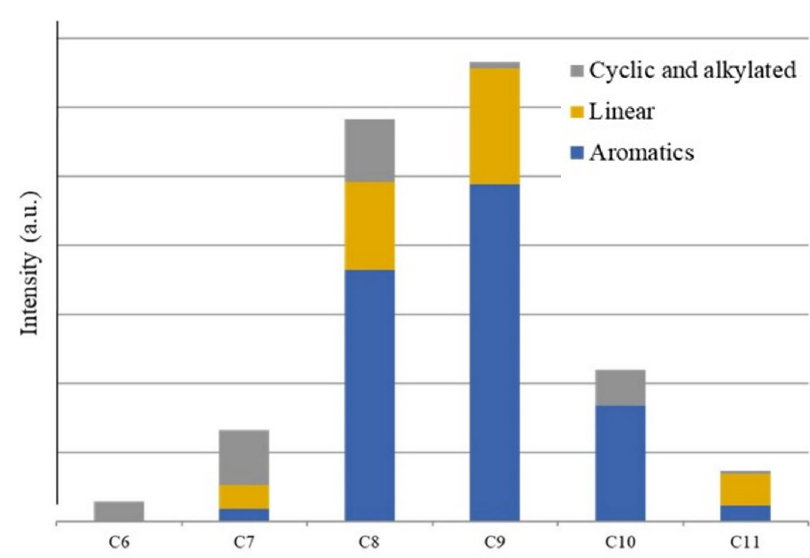
Figure 5. Distribution of hydrocarbon families in “industrial pyrolysis